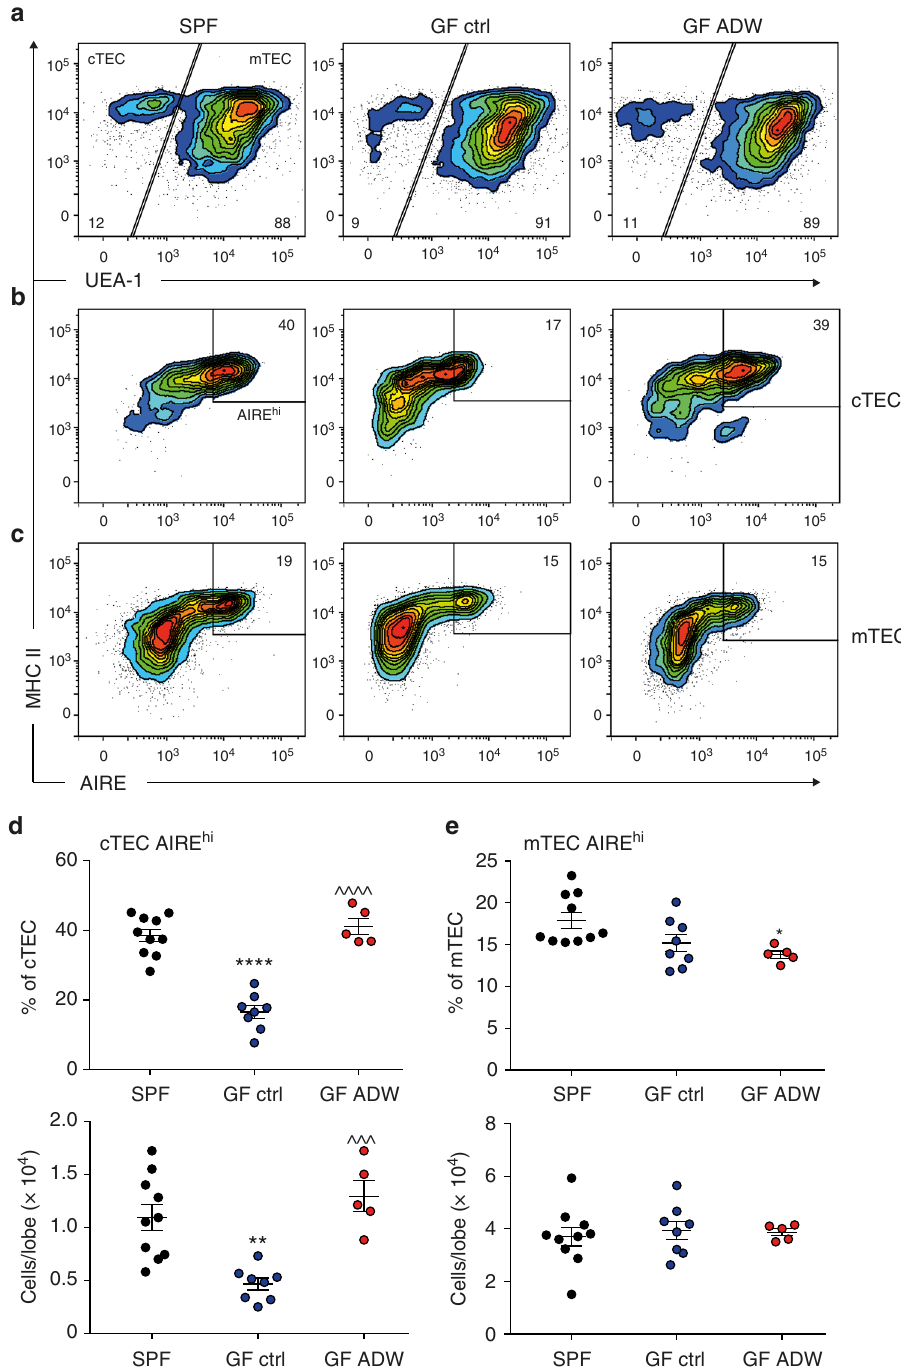
Fig. 7 Reduced thymic AIRE expression in GF pups recovered with acetate supplementation. Three-week-old C57BL/6 pups from control SPF and GF mothers and GF mothers treated with acetate in drinking water (ADW). a – c Representative fl ow cytometry analysis demonstrating AIRE expression in thymic epithelial cell subsets. d , e Flow cytometry and numerical analysis of AIRE expression in cTEC and mTEC subsets from pooled female and male pups ( n = 5 – 10/group). Asterisk denotes signi fi cance to SPF, * p < 0.05, ** p < 0.01, **** p < 0.0001; ^denotes signi fi cance to GF control, ^^^ p < 0.001, ^^^^ p < 0.0001. All data were analyzed by one-way ANOVA with Bonferroni ’ s multiple comparisons test. Data represent mean; each symbol represents an individual mouse. Data are representative of at least two independent experiments